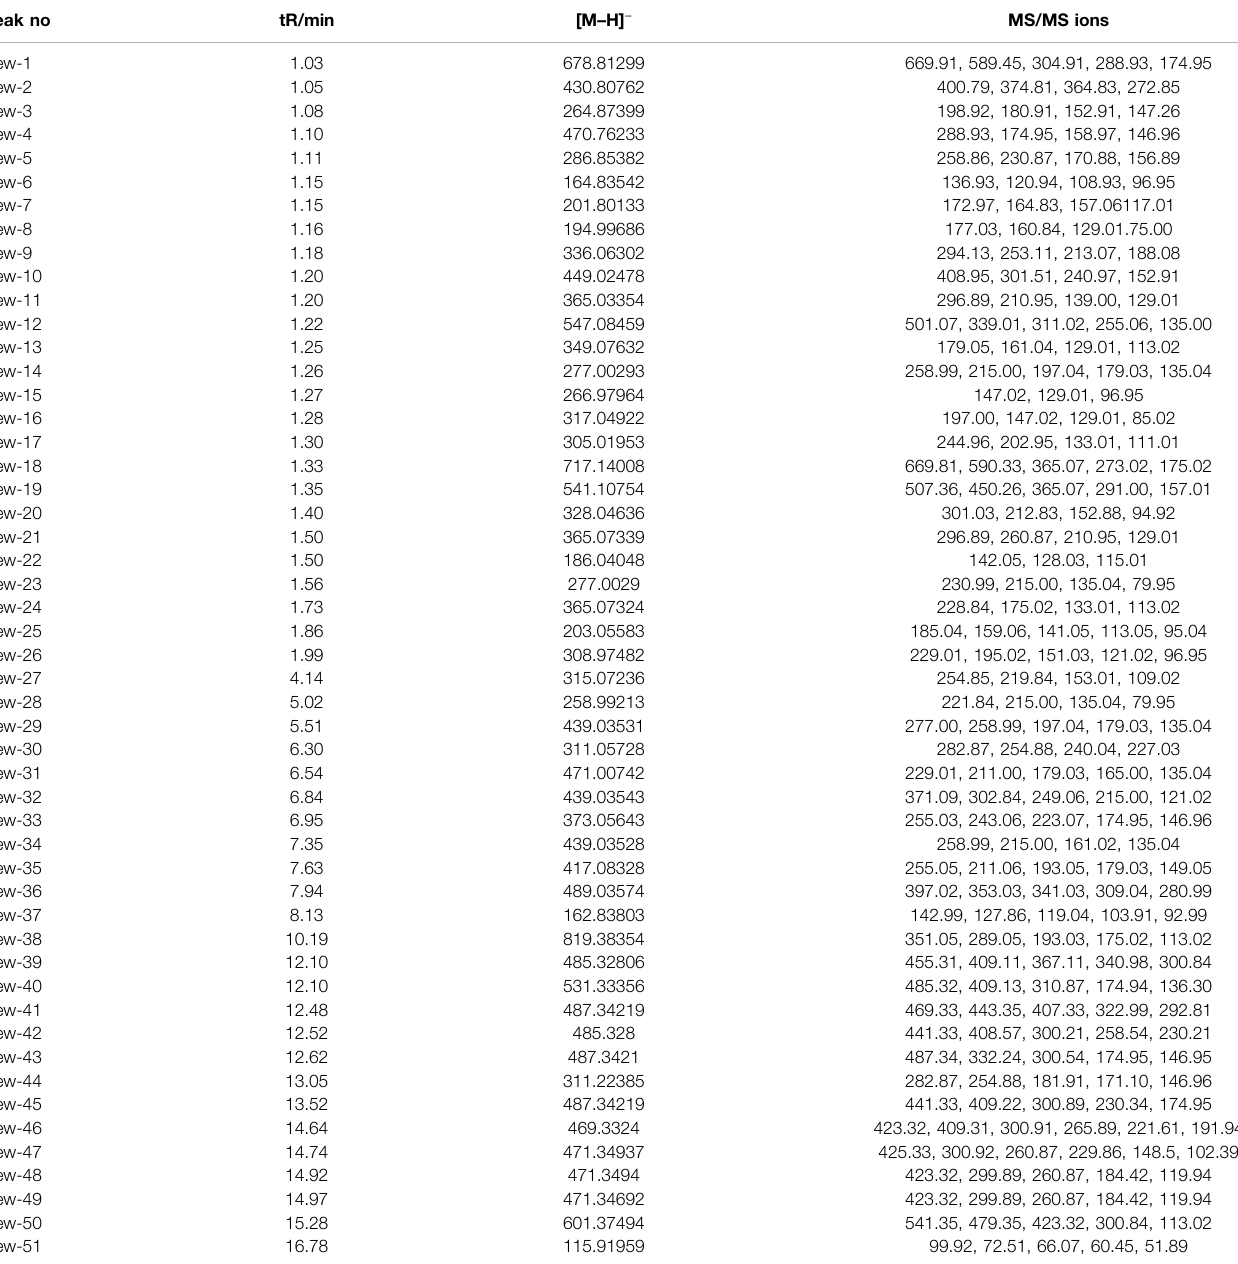
TABLE3| MSinformationofpotentialnewgeneratedcompoundsfromShuangxiadecoctionandco-decoctioncomparedwith Pinelliaternata(Thunb.)Makino and Prunella vulgaris L. decoction, separately. Peak